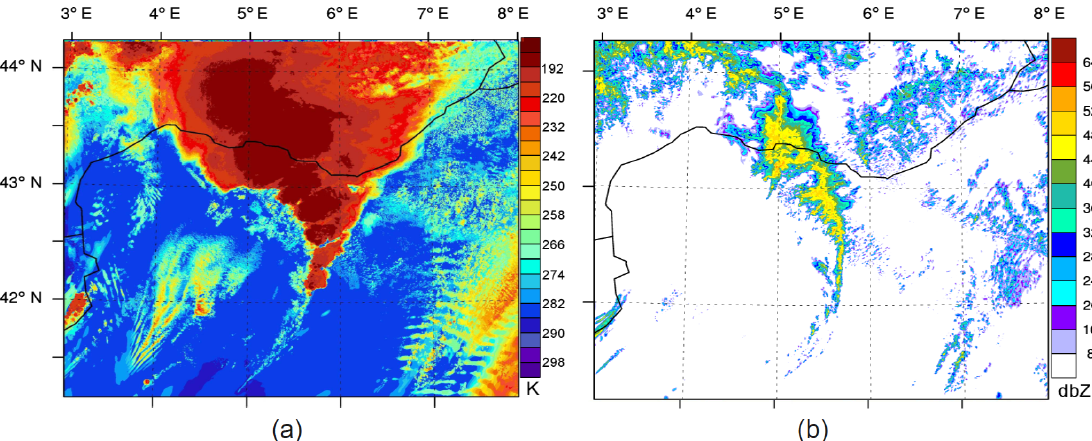
Figure 9. (a) Brightness temperature (K) and (b) the 850hPa radar reflectivity (dBz) simulated by Meso-NH at a 150m horizontal resolution on 26 October 2012 at 11:00UTC (HyMeX IOP16).